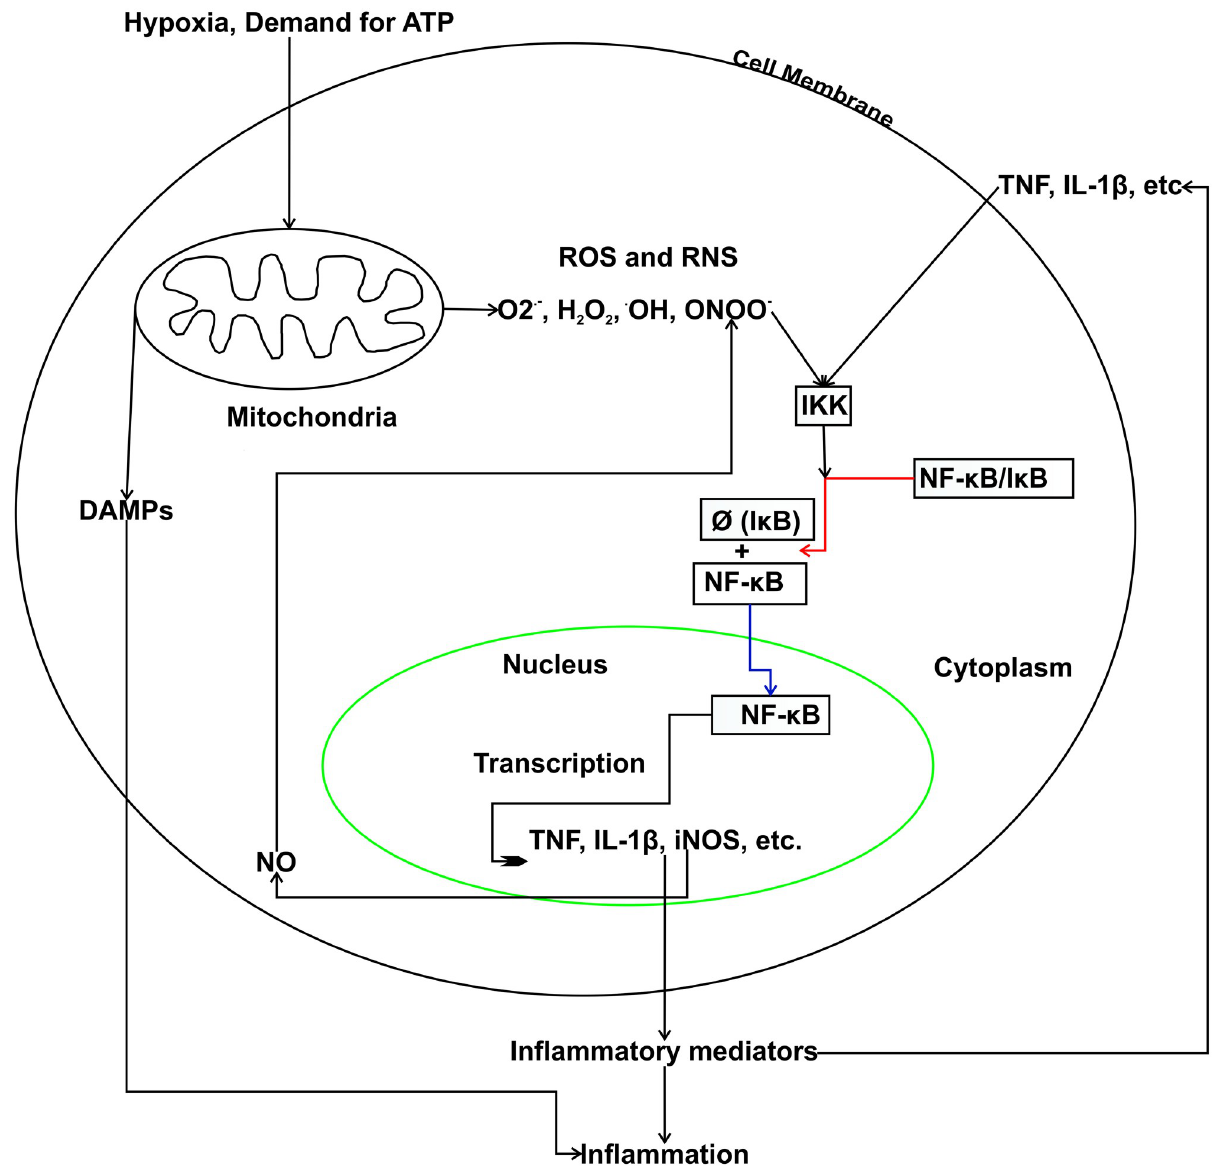
Fig 5. The proposed model for the relation between mitochondrial dysfunction and inflammation in RA. Hypoxia and demand for more ATP increase the production of mtROS and RNS, which activate the IKK enzyme that degrades I κ B (degradation is represented with Ø ). This results in the activation of transcription factor NF- κ B that induces the expression of inflammatory mediators, such as tumour necrosis factor (TNF), interleukin-1 beta (IL-1 β ) and inducible nitric oxide synthase (iNOS). Further, the damage-associated molecular patterns (DAMPs) may also contribute to